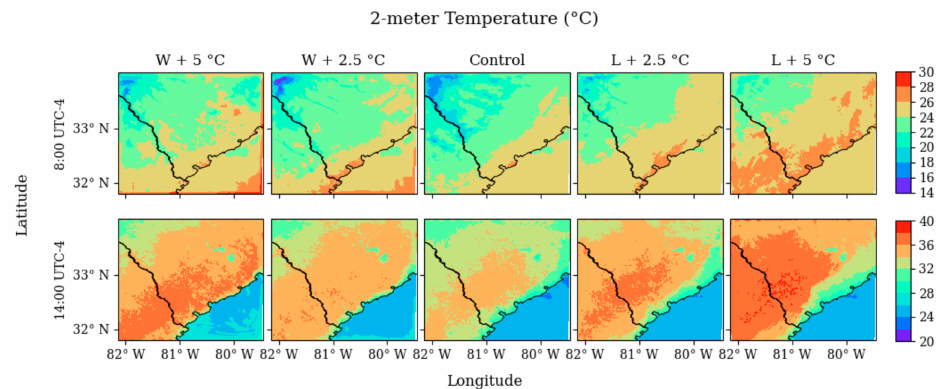
Figure 3. WRF 2-m temperature output from 21 May 2019 at 08:00 local time ( top ) and at 14:00 local time ( bottom ) over each WRF domain modification scheme. Color tables are scaled for morning and afternoon temperature ranges,